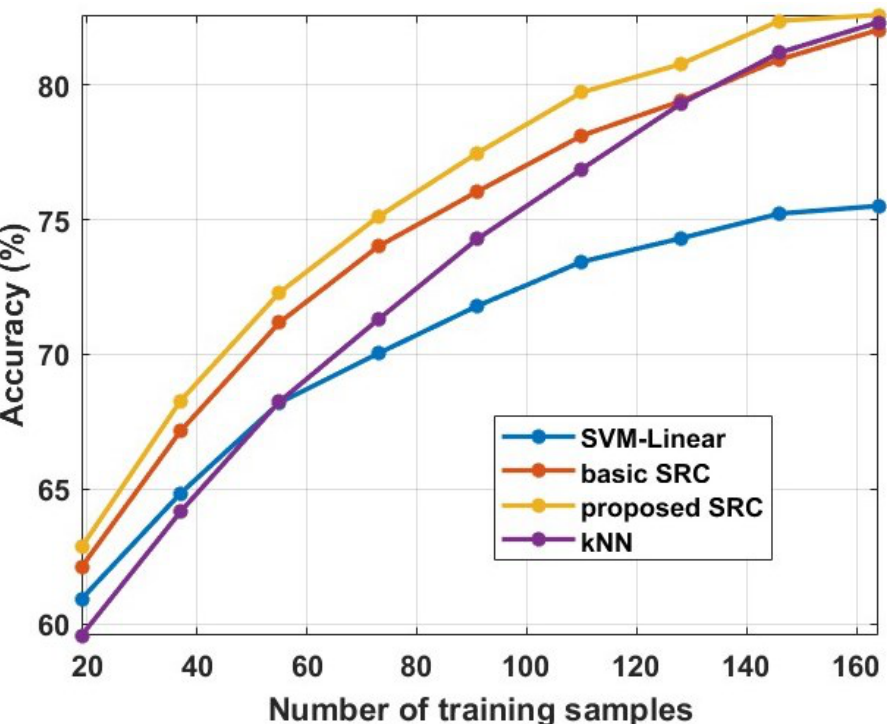
Figure 4. Averaged classification accuracy by changing the number of training samples from 20 to 160 training